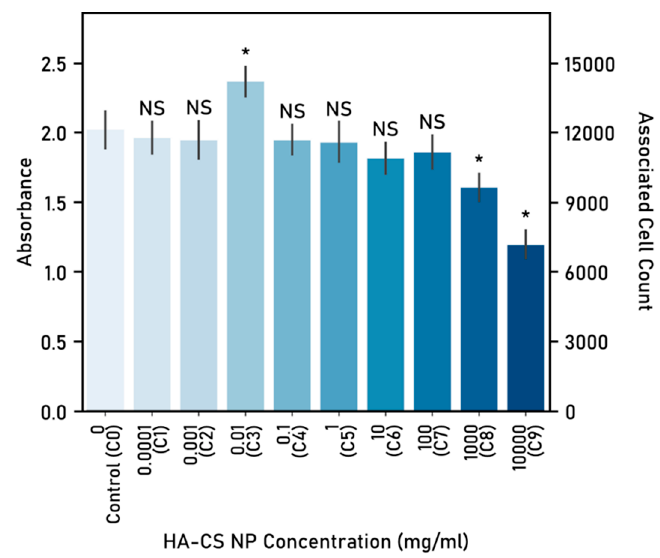
Figure 12. Determination of hyaluronic acid-chitosan nanoparticle dosage and associated cell count. Absorbance determined at 490 nm following 48 h of nanoparticle-cells co-culture. Cell seeding number: 10,000 cells, 96-well plate used, control (C0): cells-only well. Significant (*) and nonsignificant (NS) differences between samples and the control are shown. (ANOVA/Tukey, p < 0.05; n = 5). Table 6. Classification of HA-CS Nanoparticle Dosage based on Associated Cell Density. NP Concentration (mg/mL) Associated Cell Density (cells/well) Classification